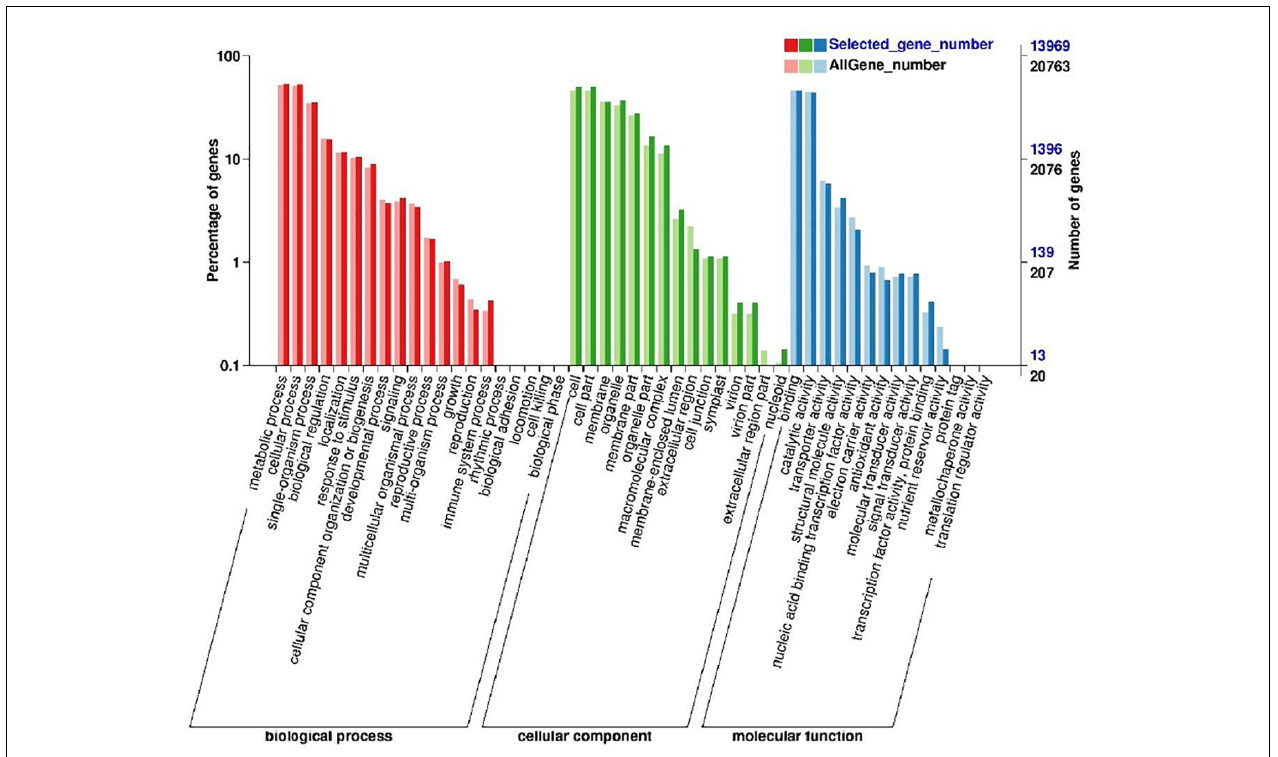
FIGURE 5 | BD banana functional classification by gene ontology (GO) analysis. A total of 13,969 unigenes have been assigned GO terms and they are classified into three GO categories: biological process, cellular component, and molecular